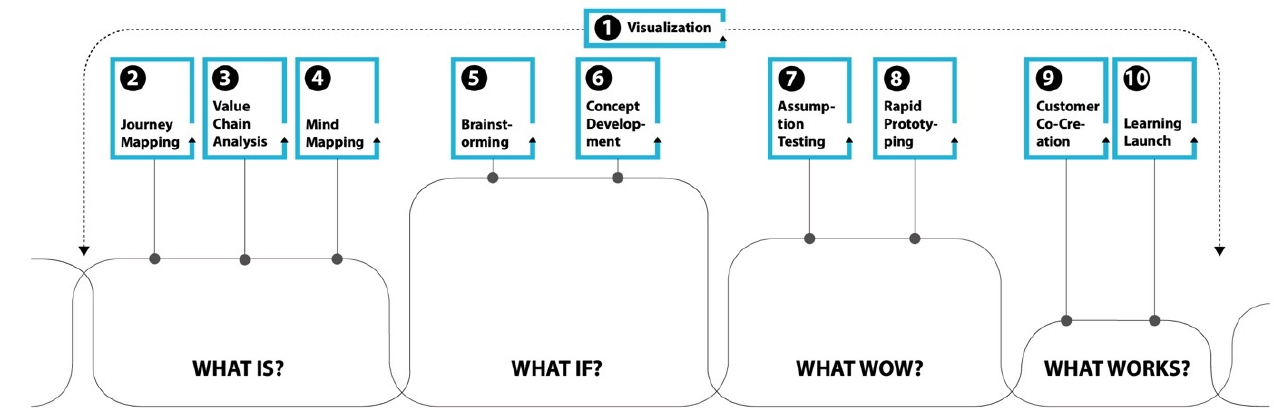
Figure 1. The design thinking process model with four questions and ten design tools as the main content. (According to ref. [81], this figure is painted by this article).